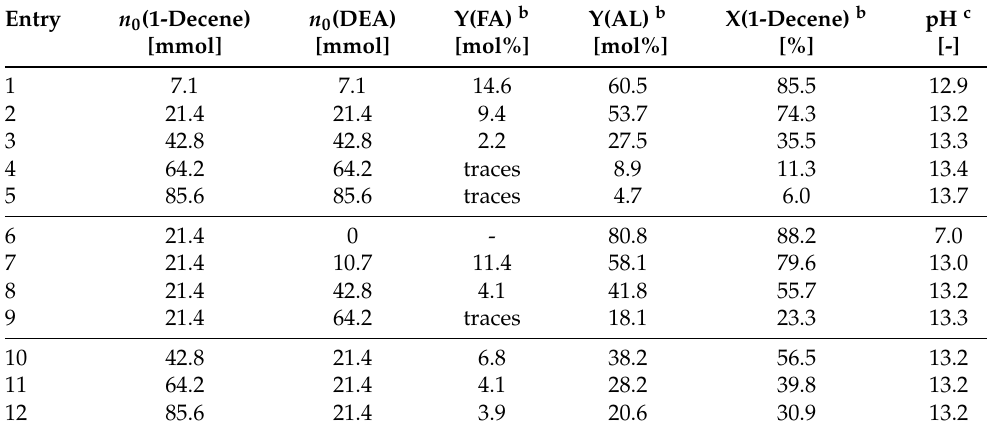
Table 3. Effect of initial amount of reactants on the hydroaminomethylation, upper section: variation of 1-decene concentration; lower section: variation of DEA concentration a